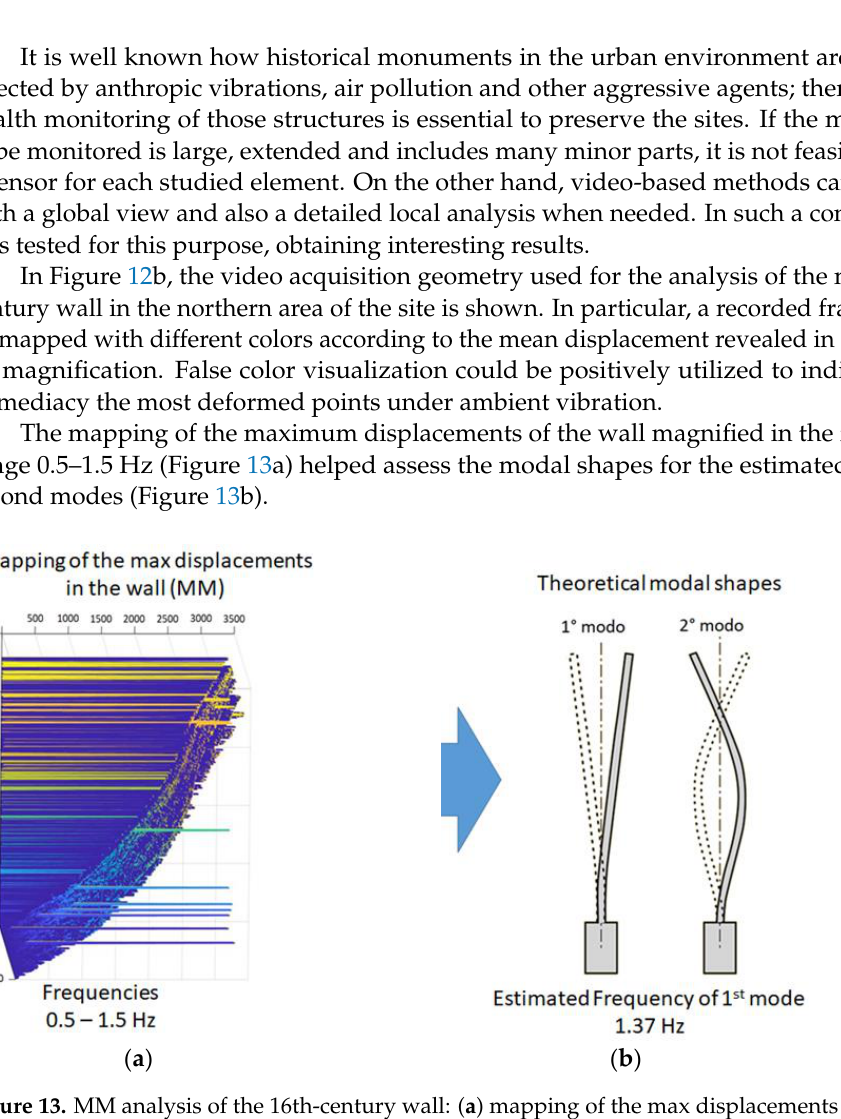
Figure 14. Columns of the Exedra: ( a ) original frame of recorded video; ( b ) relative normalized dis- placement pattern; ( c ) image entropy analysis. The analysis of the relative normalized displacement pattern helped identify the most deformable areas, which provided interesting indications about the stability of the pattern of the frescoes ’ plaster layers (Figure 15), as well as about the response of objects at different frequency ranges (Figure 16). In particular, some parts of a steel retrofitting of an arch resulted in amplified vibrations in the frequency range of 7 – 12 Hz.